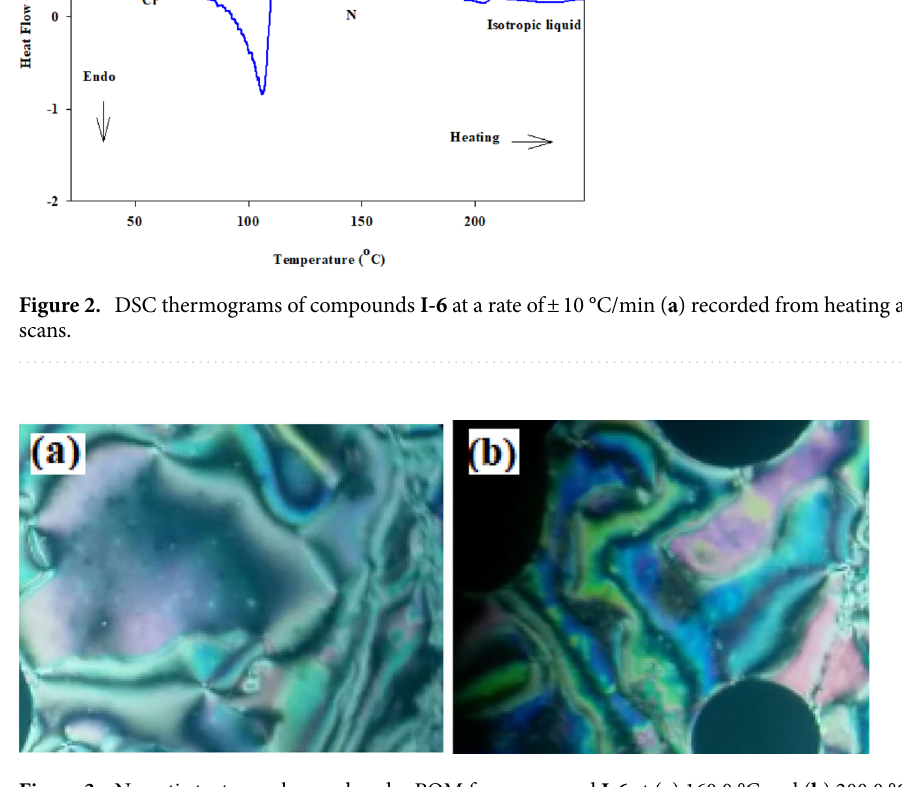
Figure 3. Nematic textures observed under POM for compound I-6 at ( a ) 160.0 °C and ( b ) 200.0 °C; the width of the images is about 40